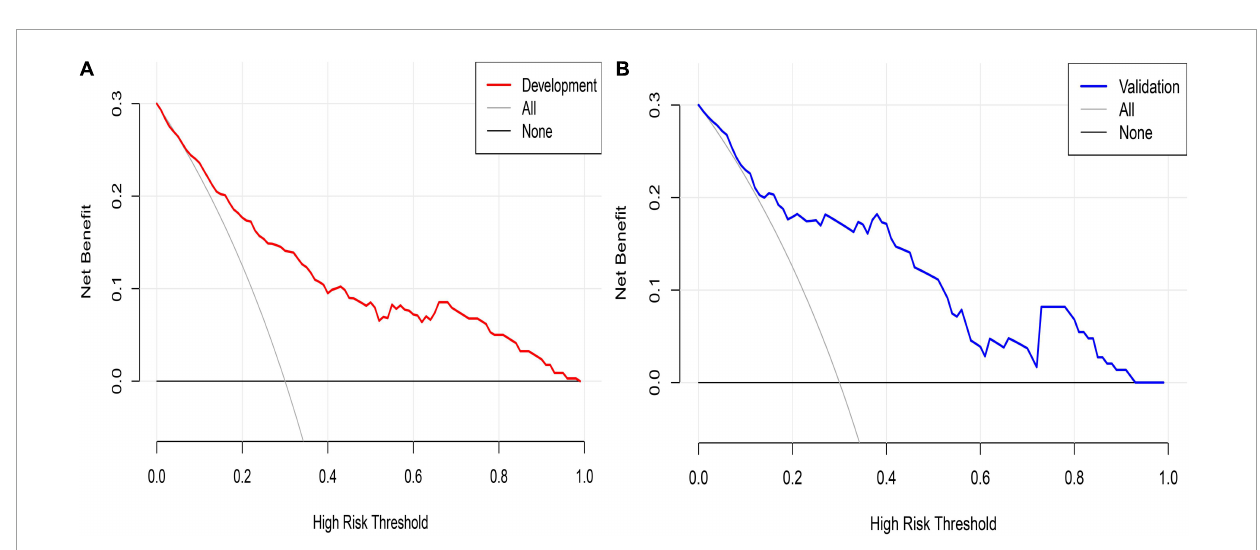
FIGURE7 Nomogram decision curve analysis for PVST prediction in HLD patients in the development (A) and validation (B) sets. The Y -axis of development and validation sets represents the net benefit, calculated as the true incidence of PVST minus the false-positive rate (true positive rate), the red and blue lines represent the nomogram prediction probability of the development and validation sets, and the gray line represents the extremes of intervention and